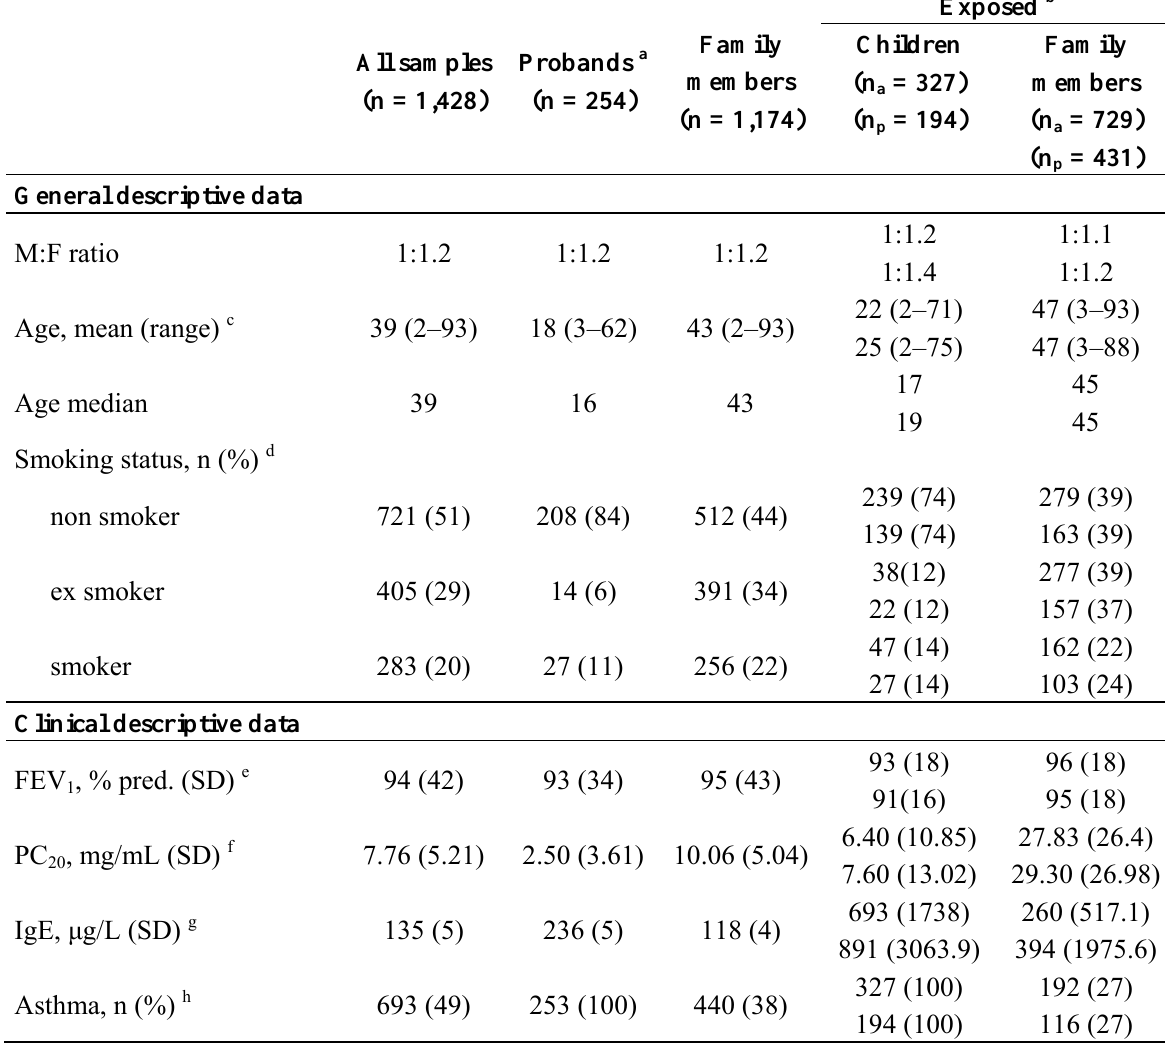
Table 1. Clinical characteristics of the Saguenay–Lac-Saint-Jean asthma